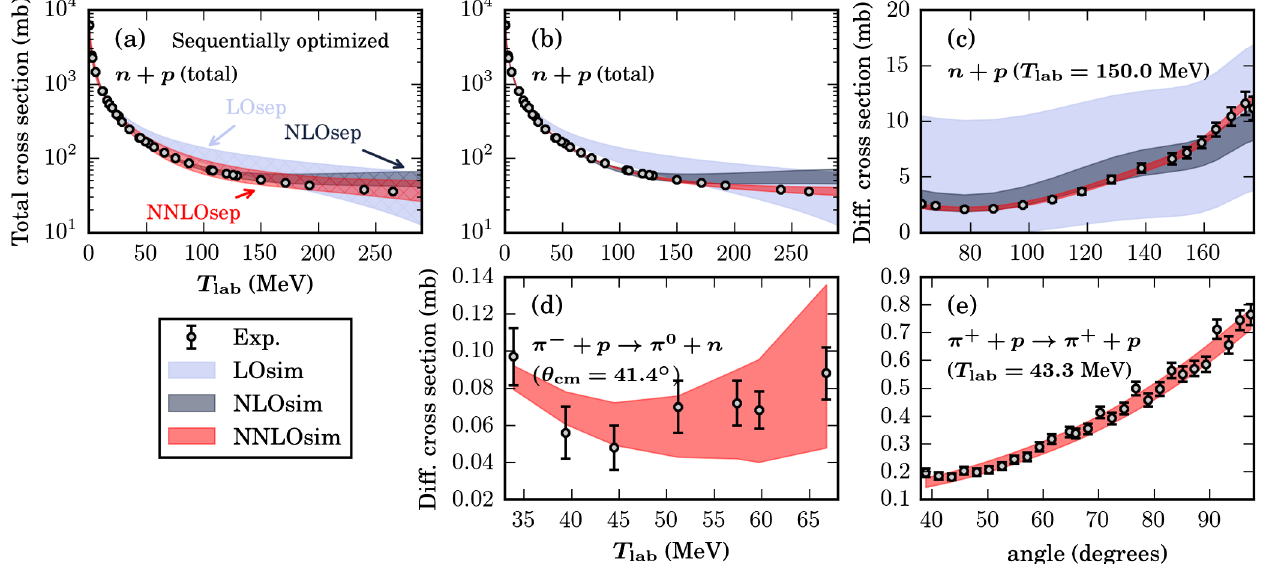
FIG. 9. Comparison between selected NN and π N experimental data sets and theoretical calculations for chiral interactions at LO, NLO, and NNLO. The bands indicate the total errors (statistical plus model errors). (a) np total cross section for the sequentially optimized interactions with no clear signature of convergence with increasing chiral order. All other results are for the simultaneously optimized interactions: LOsim, NLOsim, and NNLOsim. (b) np total cross section; (c) np differential cross section; (d) π N charge- exchange, differential cross section; (e) π N elastic, differential cross section.